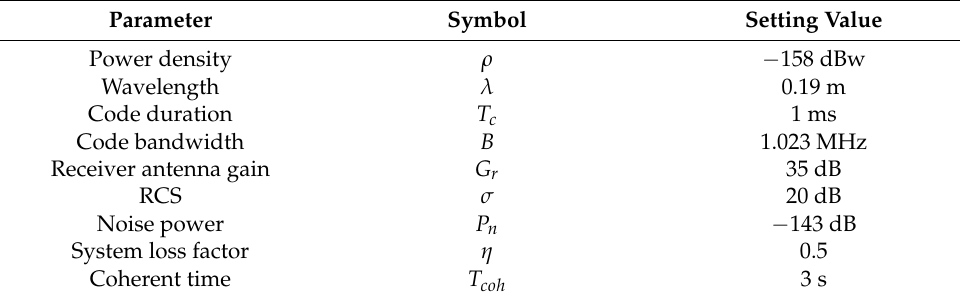
Table 3. System link budget